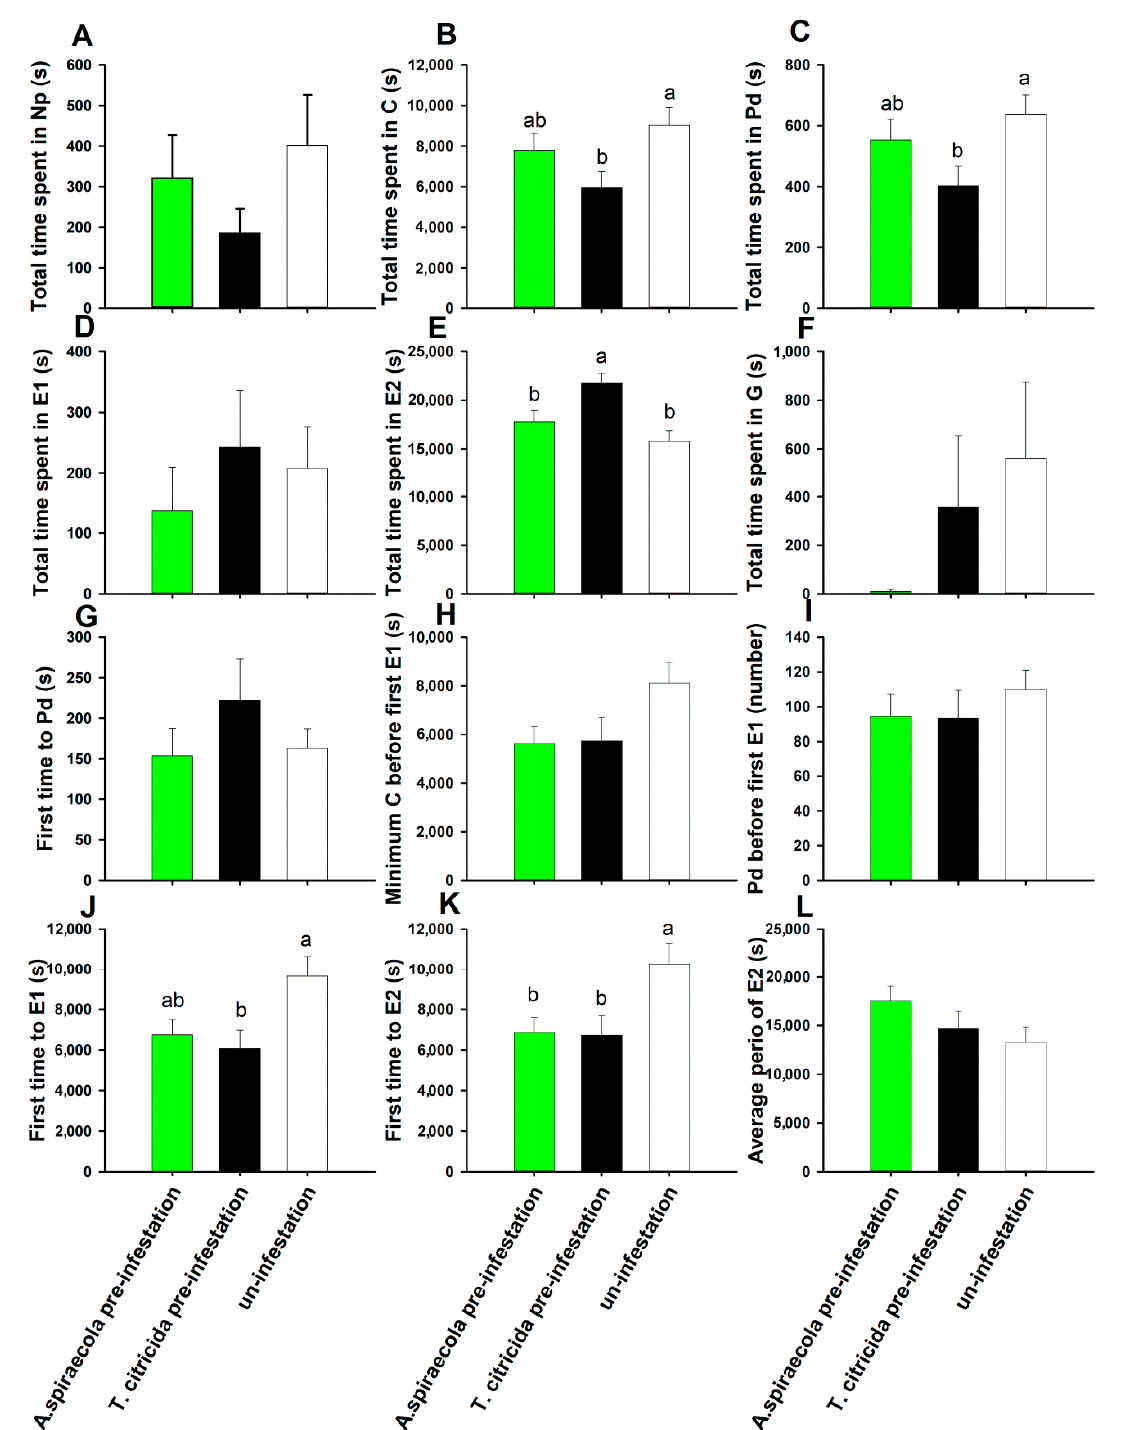
Figure 2. Effect of conspecfic and heterospecific pre-infestation on the feeding behavior of A. spiraecola . Values represent the mean ± SE (n = 21–22). Bars with different letters represent significant difference (Tukey’s HSD test, p < 0.05) in each waveform event. Bars without letters indicate there is no significant difference between treatments.